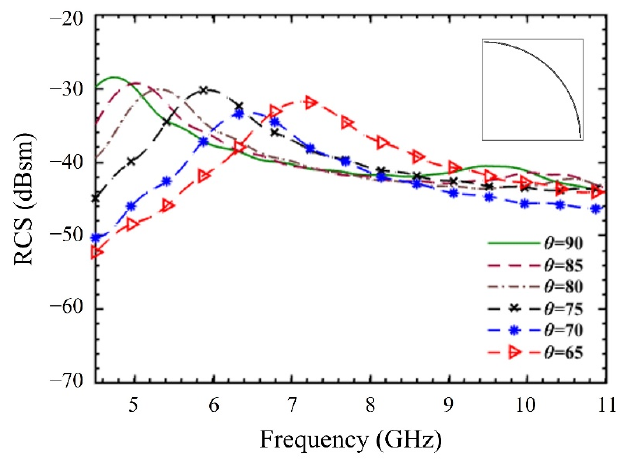
Figure 3. Effect of arc length over a single bit resonator.